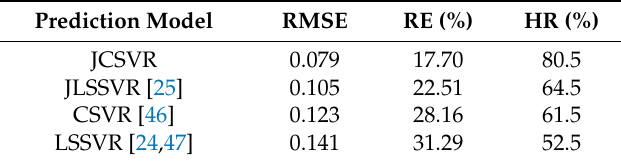
Table 3. Comparison results of online silicon content prediction for the test set using four different models.